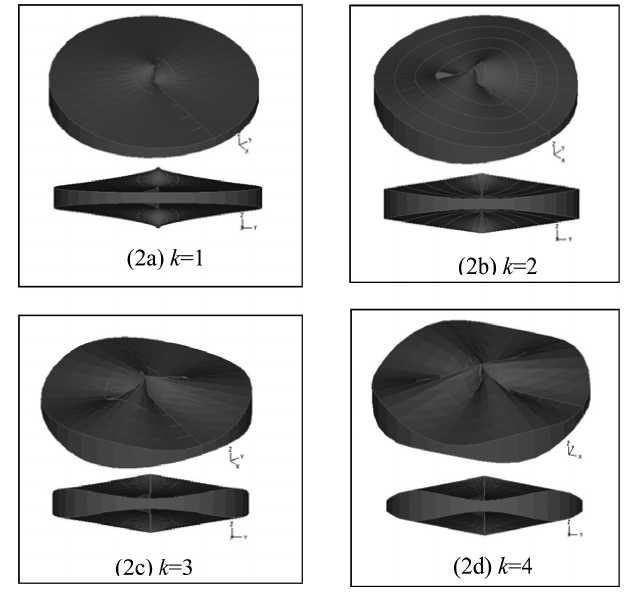
Fig. 2. Three dimensional view of plate geometry when k = 1 to